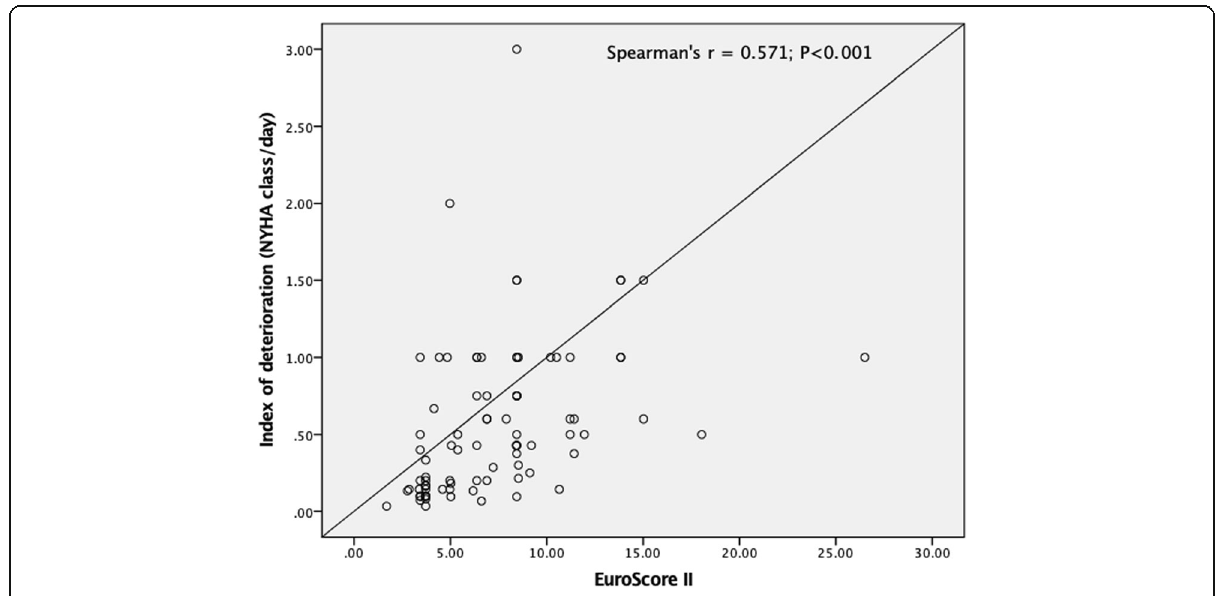
Fig. 2 Correlation between Index of deterioration and EuroScore